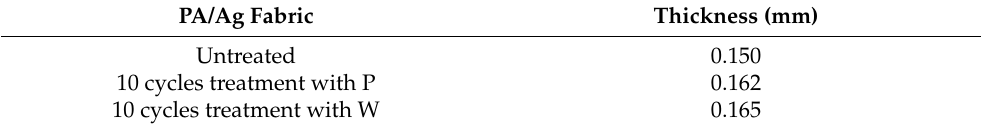
Table 2. Thickness of the PA/Ag fabric before and after 10 cycles of dry (P) and wet (W)